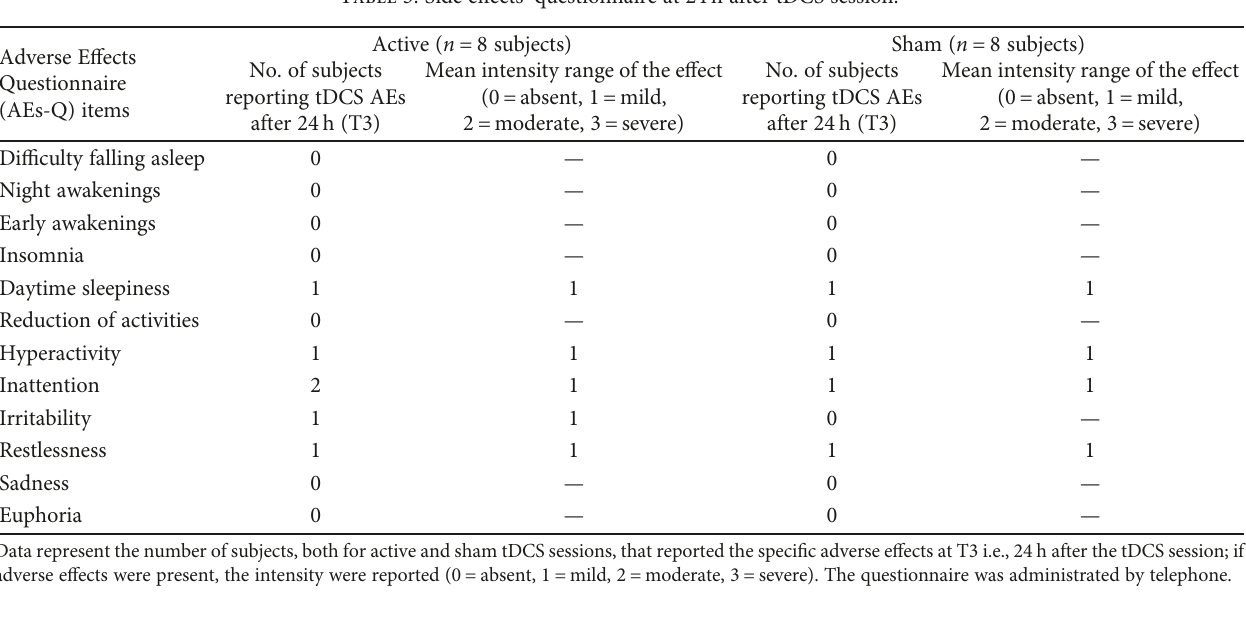
Table 3: Side e ff ects ’ questionnaire at 24 h after tDCS